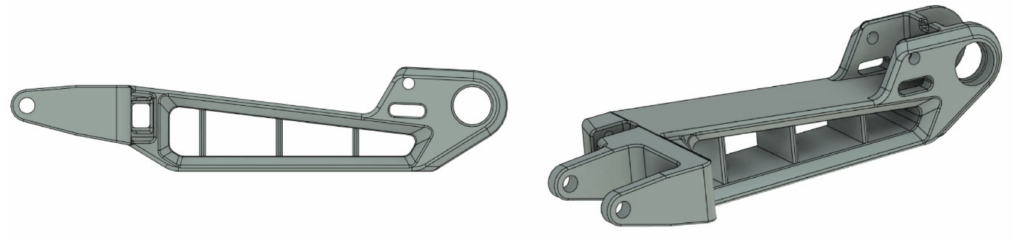
Figure 13. The final redesigned single-sided front